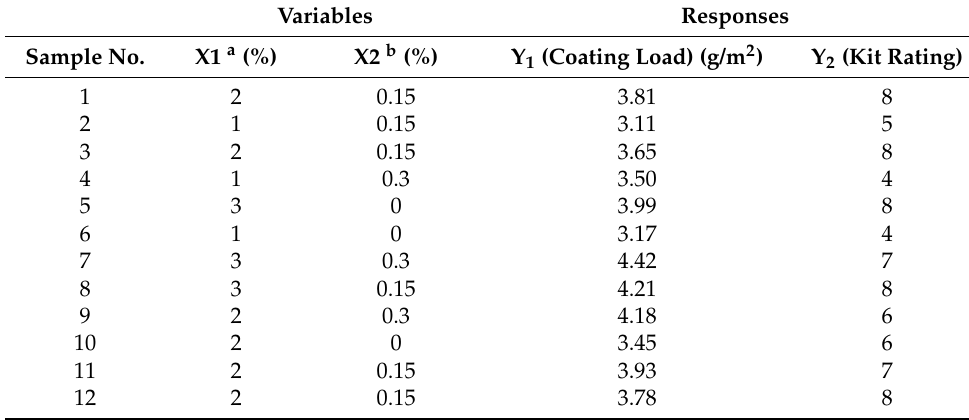
Table 1. The CCD design of experiment and experimental responses. Variables Responses